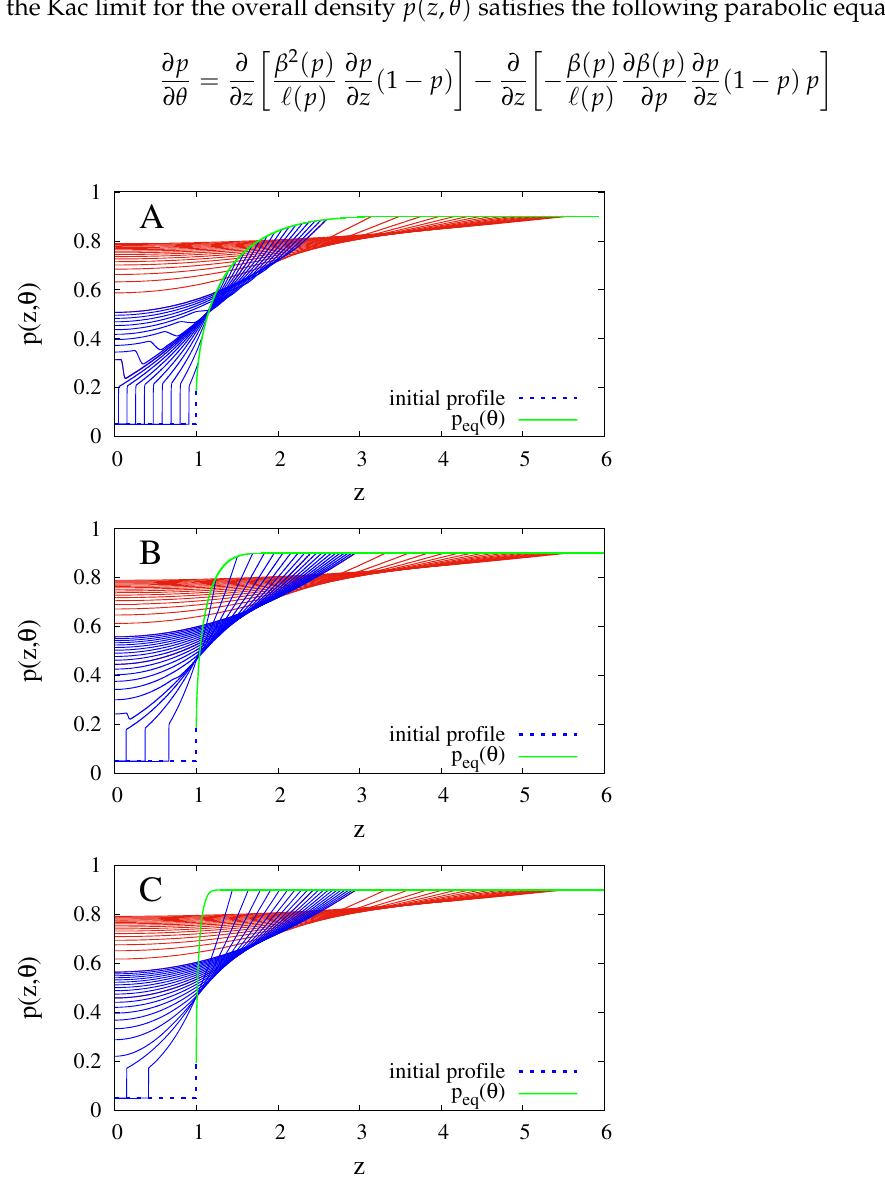
Figure 2. Spatio-temporal evolution of the overall probability density p ( z , θ ) = φ ( z , θ ) for increasing dimensionless time instants—namely, θ = 0,0.2,0.4 . . . up to θ = 2 (blue curves) and θ = 4,6,8 . . . up to θ = 40 (red curves). ( A ) De = 1; ( B ) De = 0.1; ( C ) De =